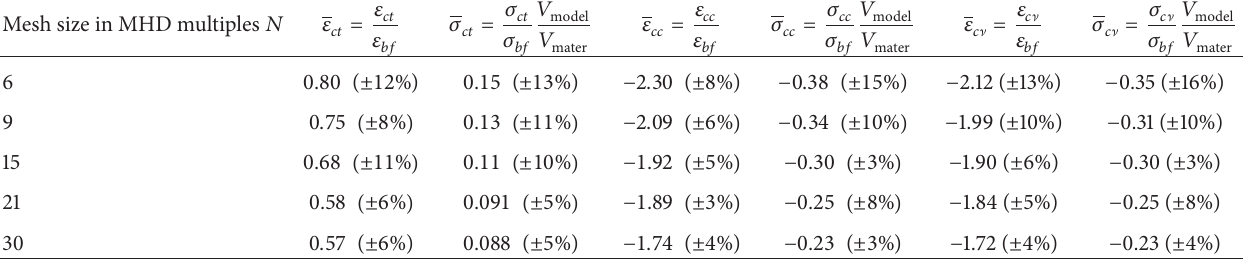
Table 1: Summary of mesh sensitivity study: normalized stresses and strains at limit points.